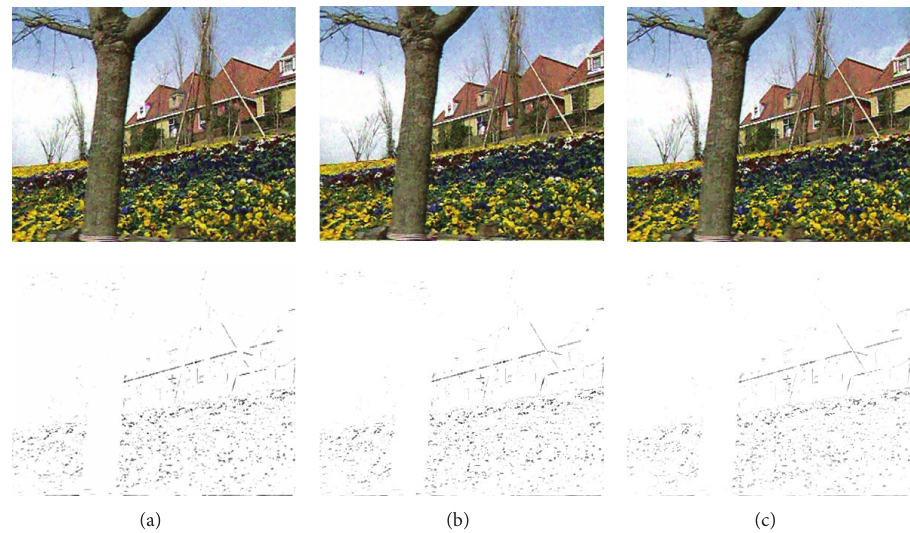
Figure 6: Filtered 20th frame of Flowers video (first row) and respective error images (second row) in case of 𝜎 2 = 0.015 noise intensity of additive noise: NLM [52] (a), VBM3D [50] (b), and FMANS 3D (c) filters. The value of each error pixel is amplified 3 times in order to distinguish the details.